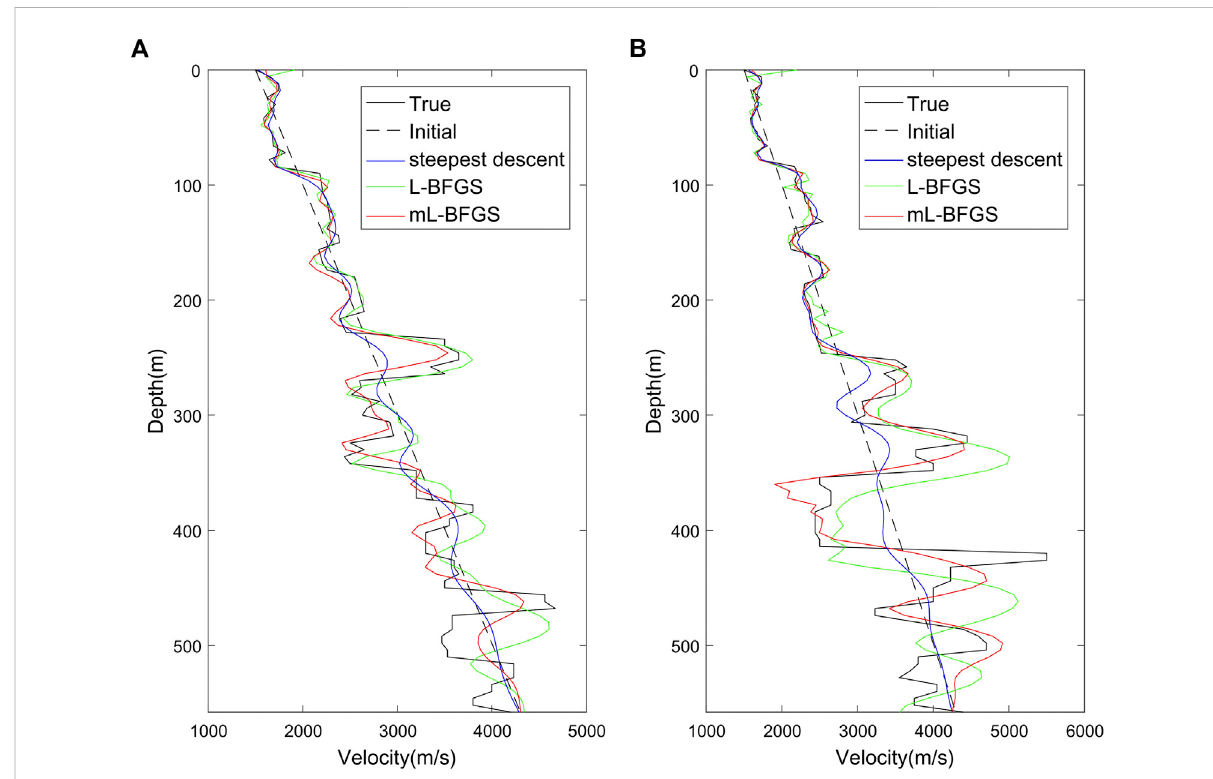
FIGURE 3 The vertical traces of the Marmousi model test at (A) 300 m and (B) 750 m. Solid black line: the true velocity; dashed black line: the initial velocity; blue line: steepest descent result; green line: L-BFGS result; red line: mL-BFGS